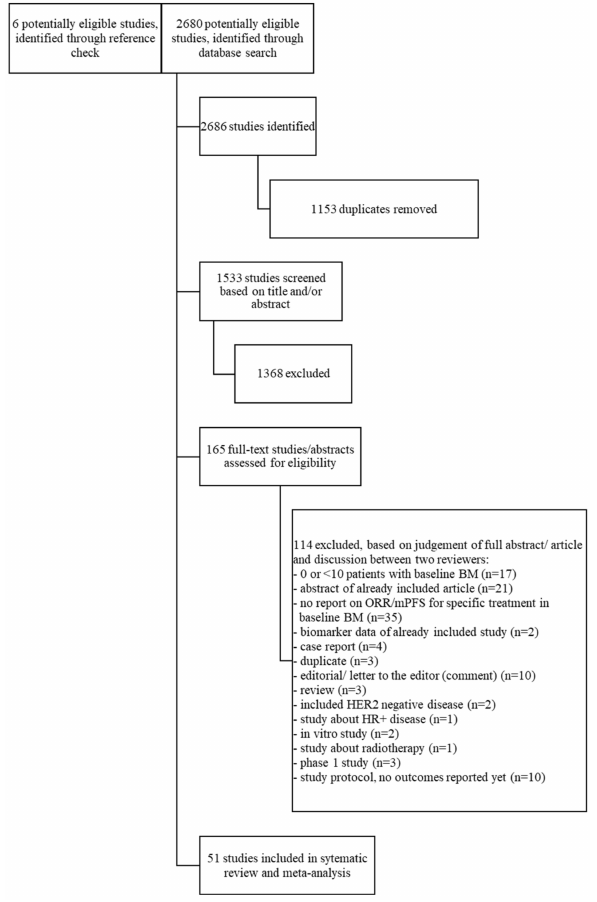
Figure 1. Flow chart of the search